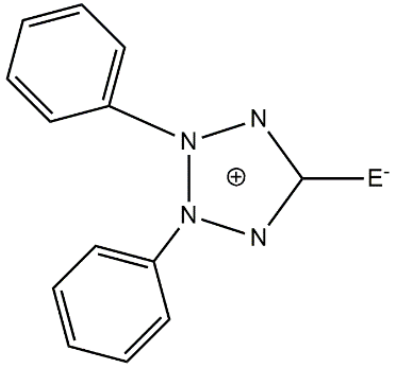
= O) and L = 1 (E 2 (E